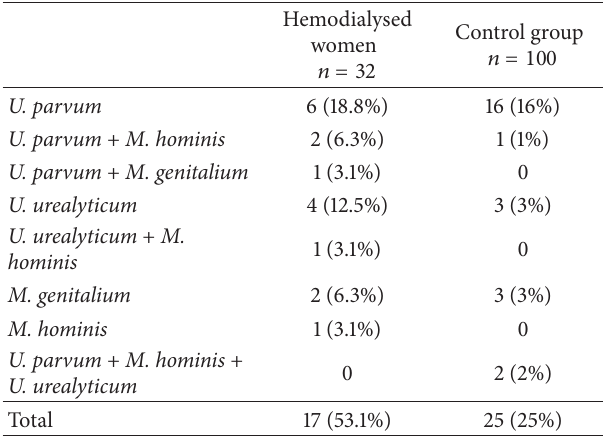
Table 1: Occurrence of urogenital mycoplasmas in hemodialysed women and the controls (the number and percentage of positive cases).